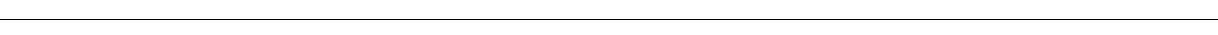
Figure 1 | The AURKA biosensor detects the autophosphorylation of AURKA on Thr288 in vitro . ( a ) Model illustrating the mode of action of the AURKA biosensor. The complete sequence of AURKA is located between the donor (D, EGFP) and the acceptor (A, mCherry) fluorophores. When AURKA is autophosphorylated on Thr288, the kinase undergoes a conformational change bringing the donor and the acceptor in proximity and allowing FRET detection. Of note, the real three-dimensional orientations of the two fluorescent proteins are not known. ( b ) (Left panels) Representative fluorescence (GFP channel) and lifetime images from in vitro FLIM analysis of purified GFP-AURKA and GFP-AURKA-mCherry proteins. (Right panel) The graph illustrates a time-lapse analysis of the fluorescence lifetime of EGFP for both proteins. Images were acquired every 5min. Data represent means ± s.e.m. of three independent experiments. ( c ) (Left panels) Representative fluorescence (GFP channel) and lifetime images taken at selected time points, and (right panel) corresponding quantification of the in vitro FLIM analysis of GFP-AURKA and GFP-AURKA-mCherry following l PP and ATP treatments. All treatments were performed at 30 (cid:2) C and images were acquired every 5min. The addition of l PP and ATP is indicated by an arrow on the graph. Data represent means ± s.e.m. of three independent experiments. The pseudocolour scale in b , c represents pixel-by-pixel lifetimes; conditions and/or time points are indicated in italics. Scale bar, 5 m m. *** P o 0.001 against each time point in the corresponding ‘GFP-AURKA’ condition; NS, not significant. Statistical tests: two-way ANOVA. ( d ) Representative in vitro kinase assay and corresponding western blot analysis showing the proportion of AURKA undergoing autophosphorylation on Thr288 (AURKA pThr288) in samples incubated at 30 (cid:2) C with l PP for 1h and then treated or not with ATP for 1h at the same temperature. Loading control: total AURKA. ( e ) Representative in vitro kinase assay illustrating the presence of a Ser10-positive band on